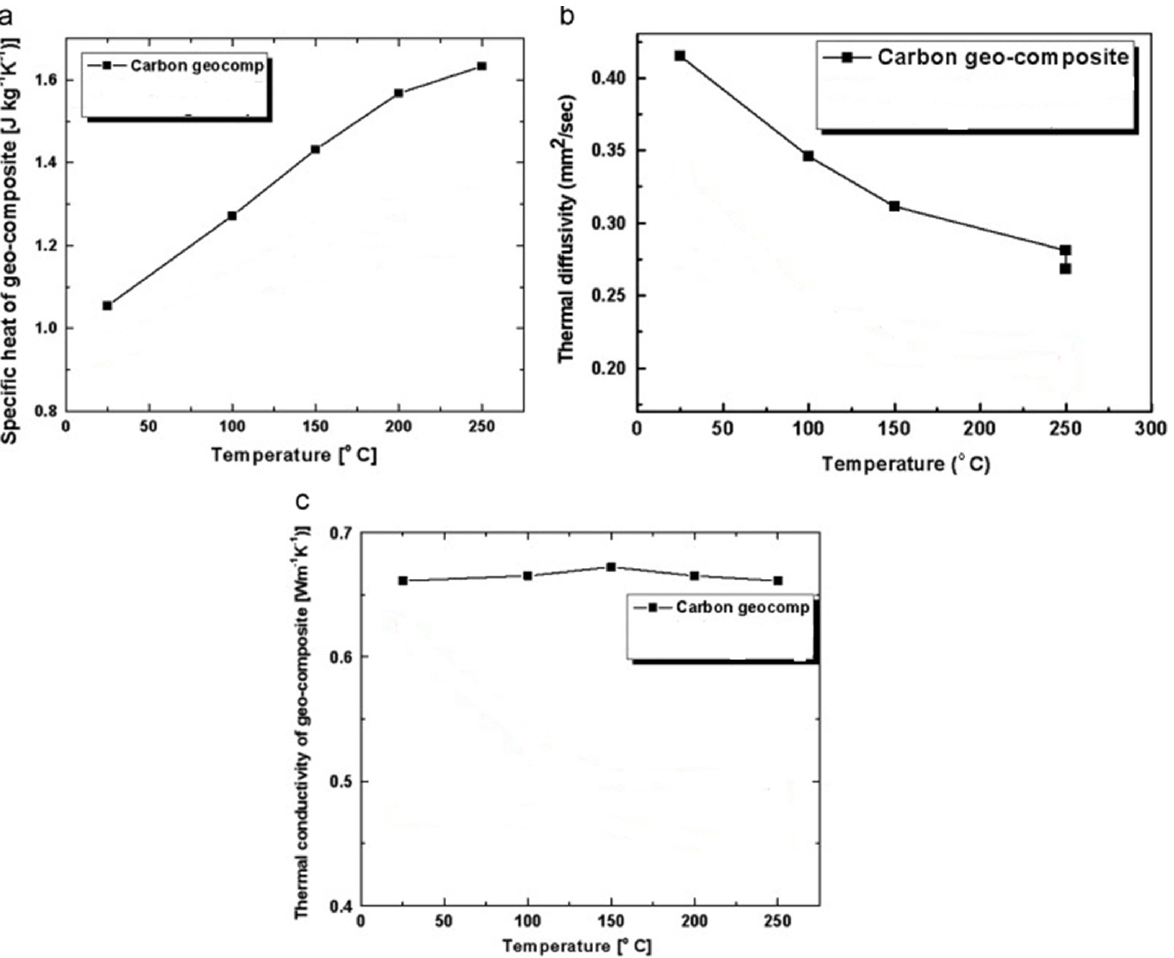
Figure 11. ( a – c ) Specific heat capacity, thermal diffusivity, and thermal conductivity of carbon fiber reinforced geopolymer composite at various annealed temperatures.